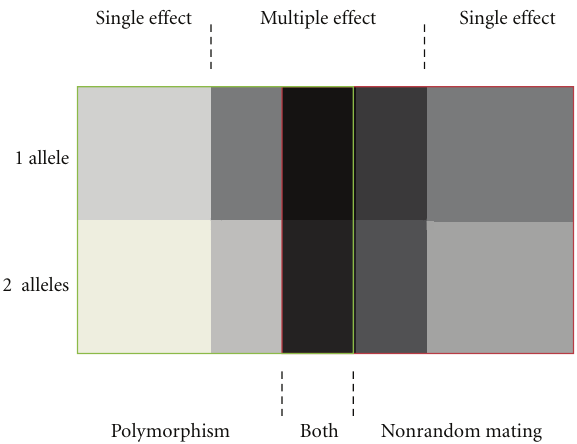
Figure 1: Habitat choice and the probability of speciation. Darker colours represent increased probability of speciation. See main text for further